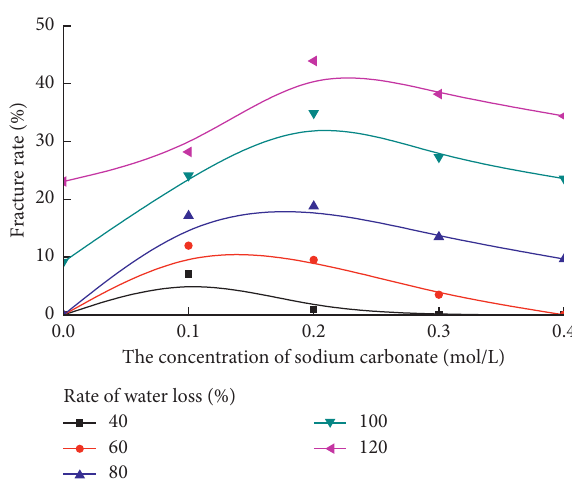
Figure 6: Relationship between the crack ratio and the crack length of the soil.